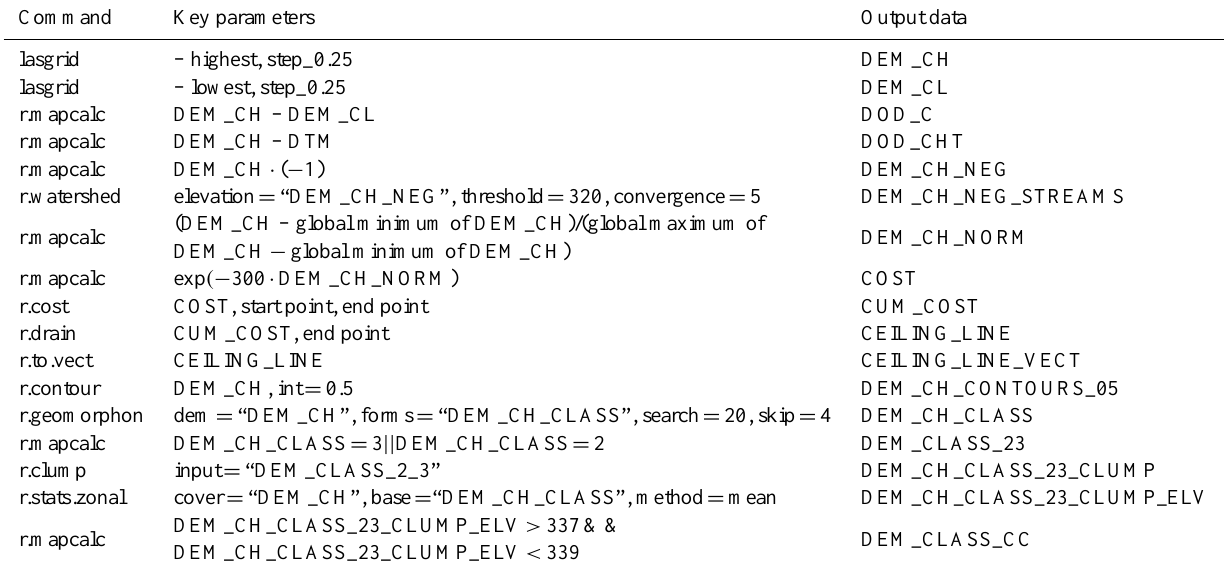
Table 3. Computer commands and their key parameters for generating the data listed in Table